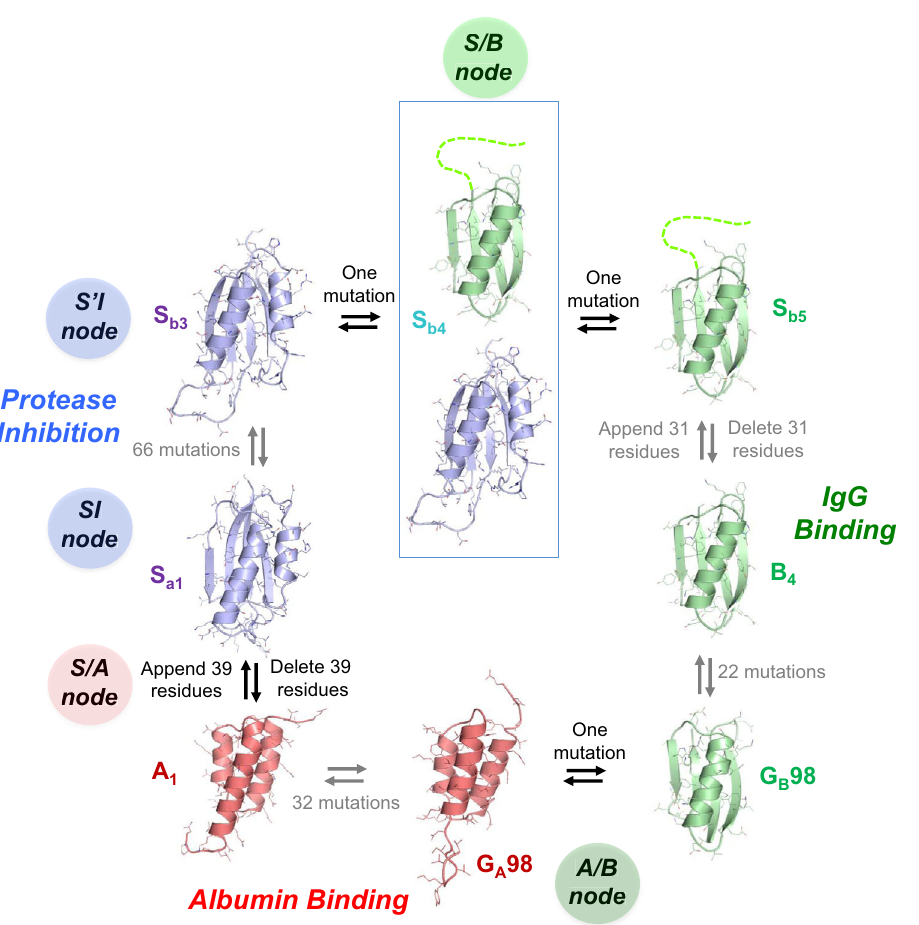
Fig. 9 | Sequence-fold relationships of engineered S/A, S/B, and A/B nodes. Switches between stable folds can be induced by a single amino acid mutation or deleting/appendingterminalsequencethatstabilizestheS-fold.BluedenotesanS- fold,greenaB-fold,andredanA-fold.Grayarrowsconnectproteinsthathavebeen